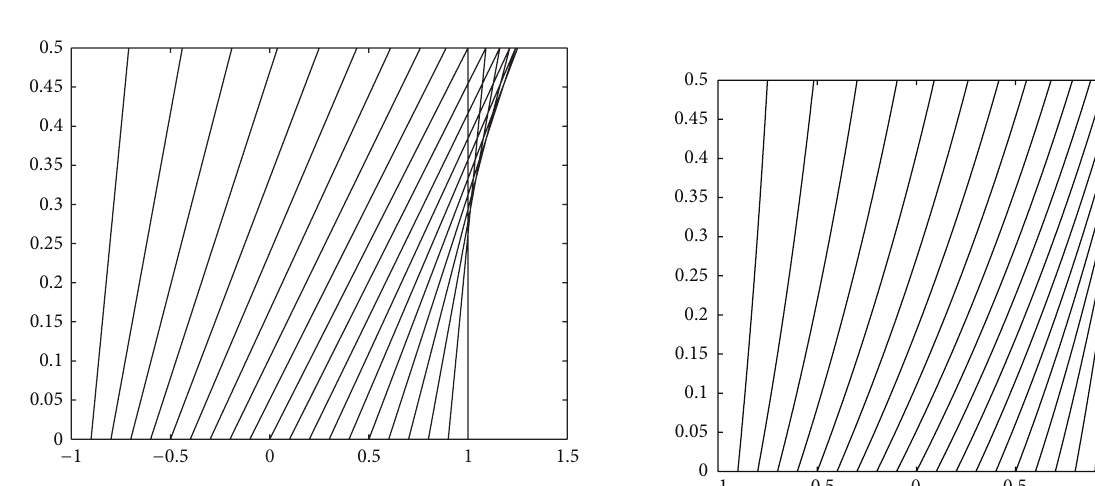
Figure 3: Linear damping 𝐴 = 1/2 .